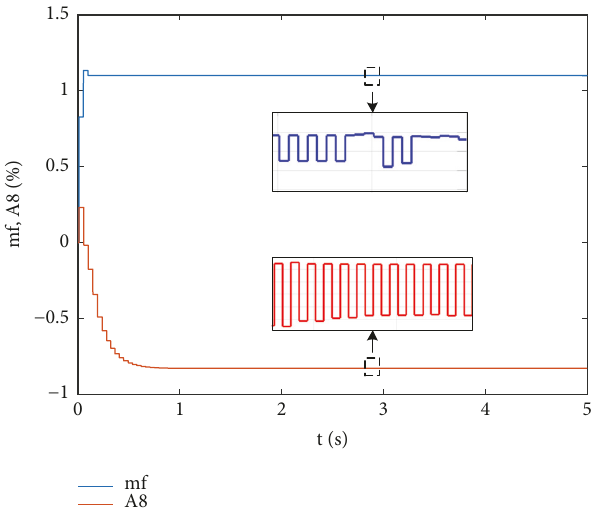
Figure 4: Input signals for the aeroengine model ( T =0.015s, P =3).